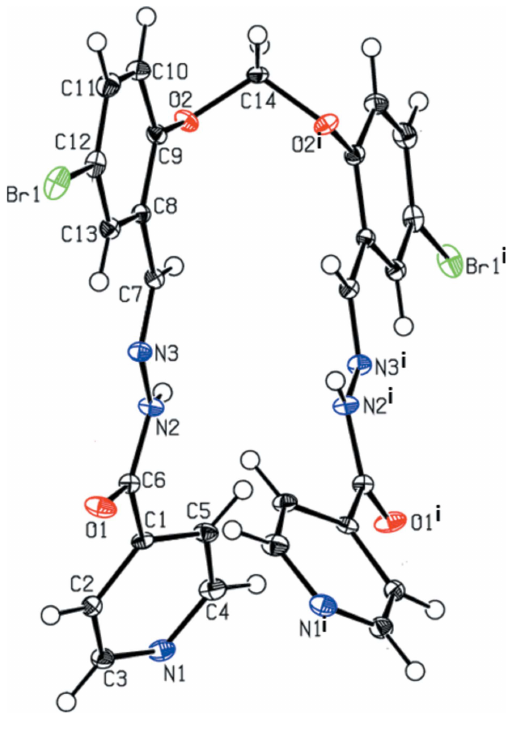
Figure 1 View of the molecular structure of compound (I), with the atom labelling. Displacement ellipsoids are drawn at the 50% probability level. Unlabelled atoms are related to labelled atoms by a twofold rotation